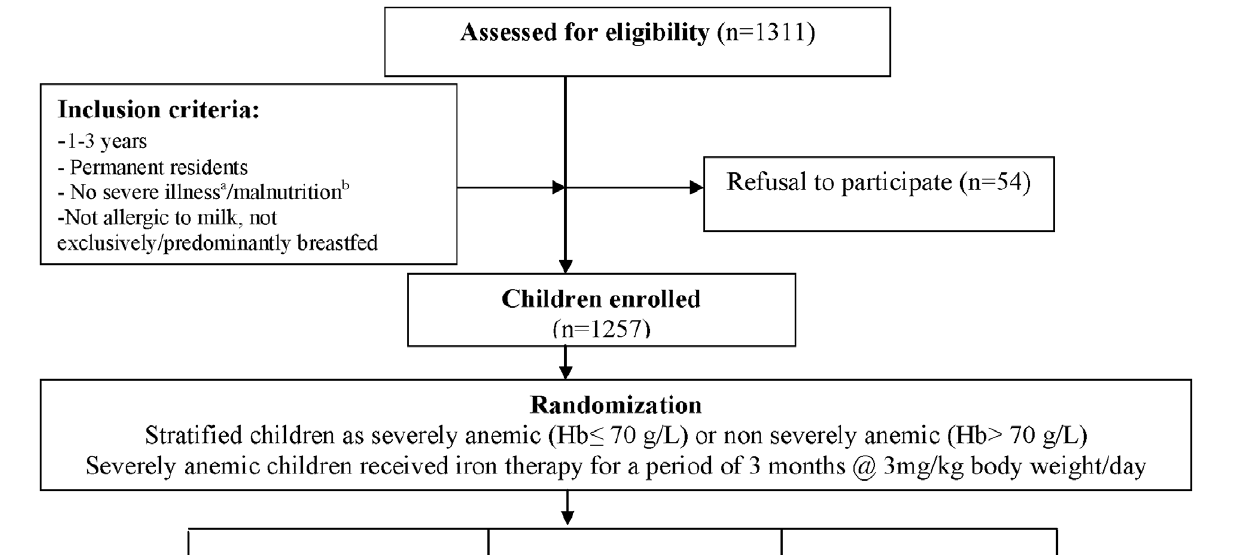
Figure 1. Schematic representation of trial design. doi:10.1371/journal.pone.0012164.g001 Overall, children in the PP group had 6% lower rate of diarrhea (95% CI: 2 1 to 12%; p =0.08) compared to children in Co group. Ancillary analysis based on age revealed a significant age interaction, therefore making overall rate reduction less meaning-